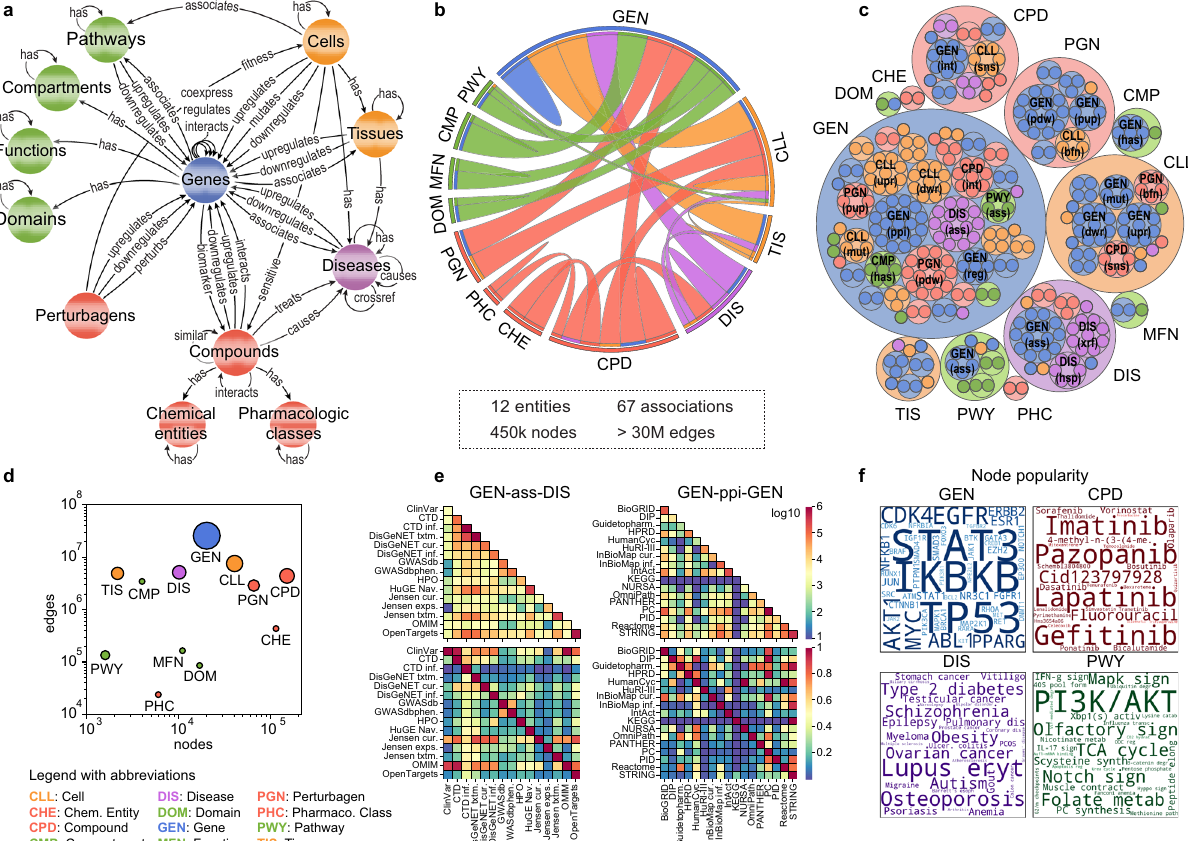
Fig. 1 | Building the Bioteque knowledge graph (KG). a Metagraph of the Bio- teque, showing all the entities and the most representative associations (metaed- ges) between them. b Circos plot representation of the KG, showing the relationships between nodes. c Treeplot showing the number of datasets used to construct each metaedge. d Total number of nodes (x-axis) and edges (y-axis) available for each entity type. The size of the circles is proportional to the number of metaedges in which the entities participate. e Number of edges (top row) and